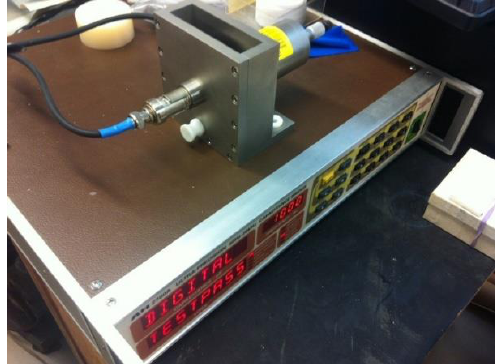
Figure 4. The air-gap capacitance bridge equipment setup.